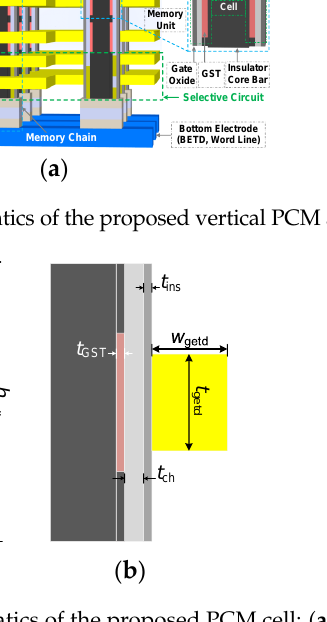
Figure 3. Schematics of the proposed PCM cell: ( a ) top view; ( b ) side view.